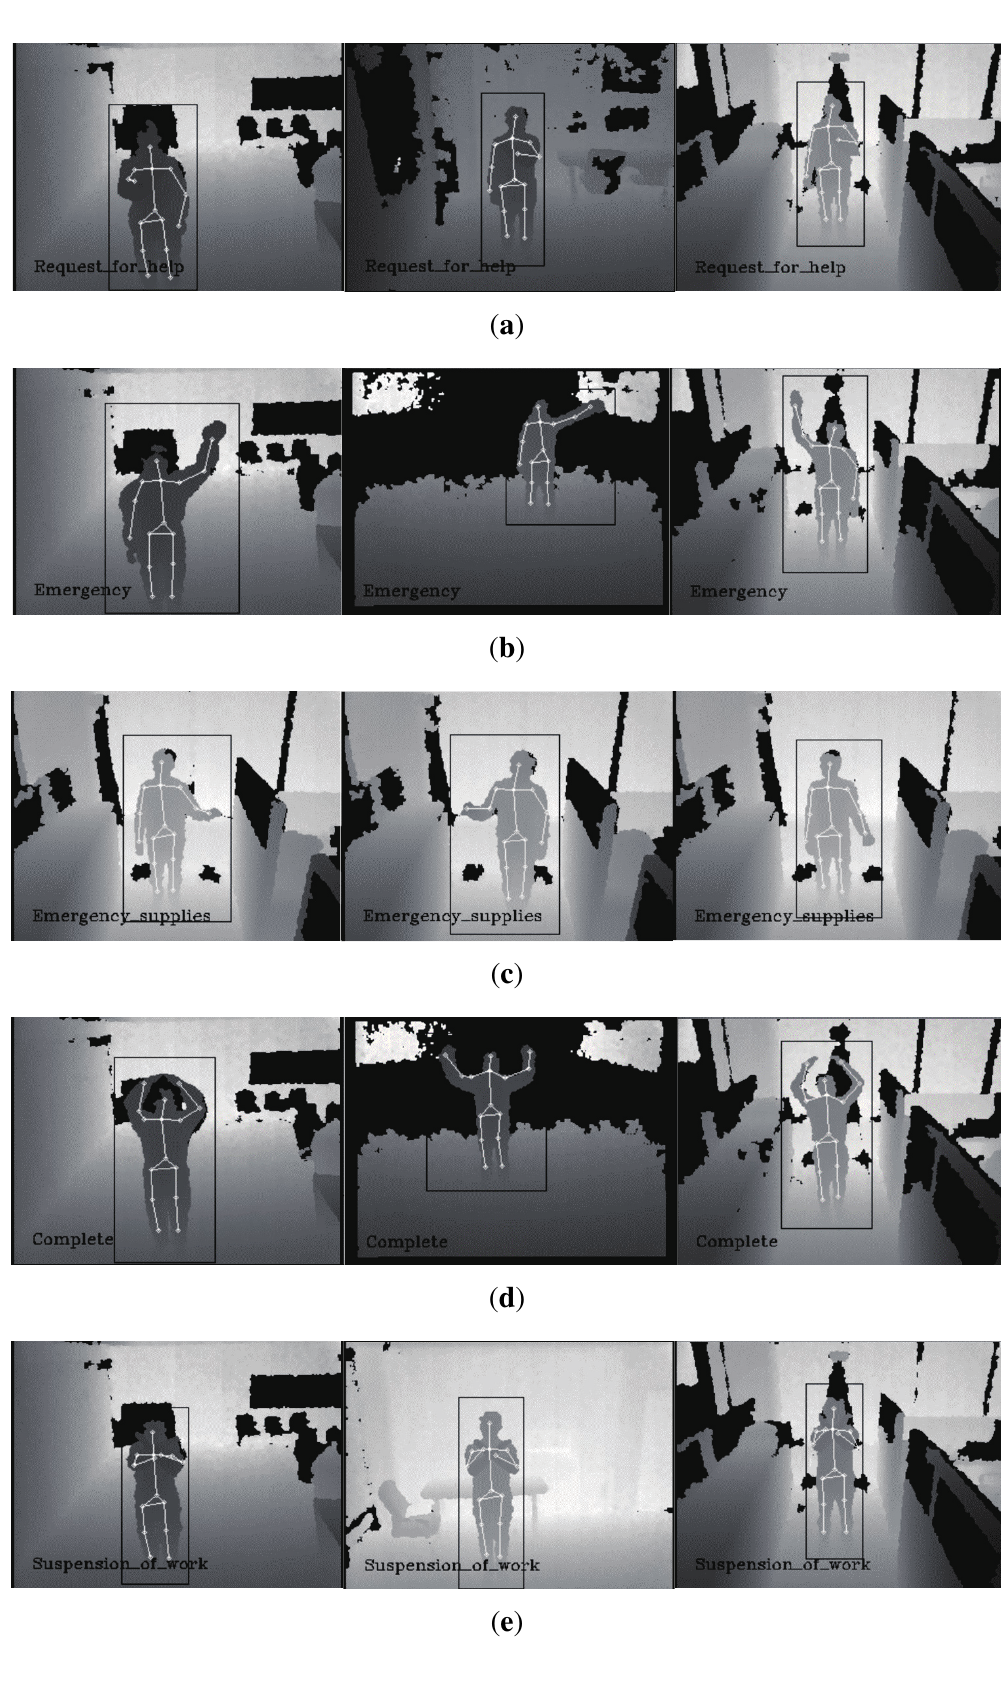
Figure 9. Example experimental results of gesture recognition. ( a ) The experimental results: “request for help”; ( b ) the experimental results: “emergency”; ( c ) the experimental results: “request for emergency supplies”; ( d ) the experimental results: “complete”; ( e ) the experimental results: “suspension of